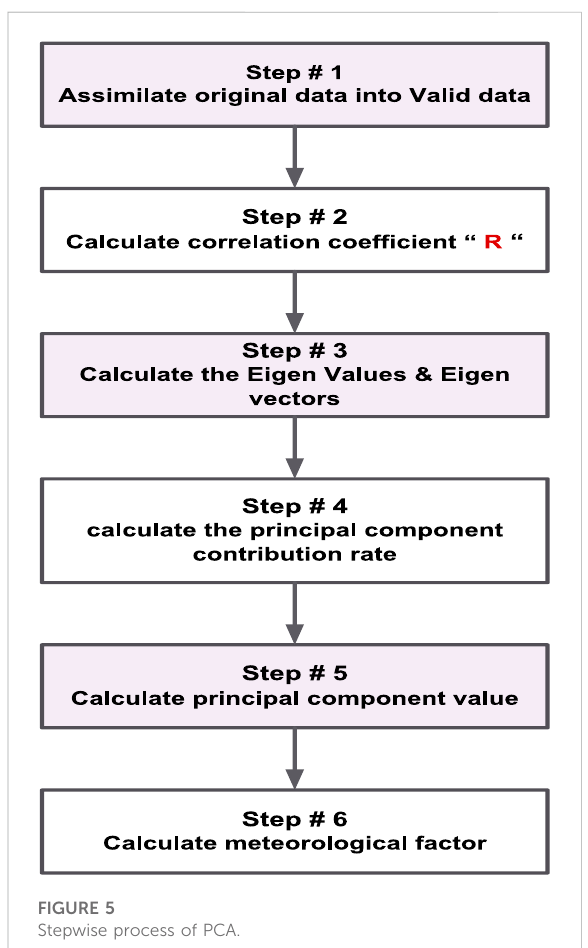
FIGURE 5 Stepwise process of